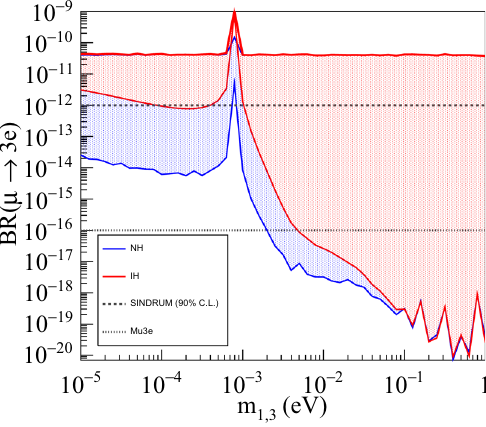
Fig. 3 Branching ratio of the process μ → e γ vs lightest neutrino mass, m 1 ( m 3 ) for NH (IH) due to the combined effect of heavy right handed and sterile neutrino